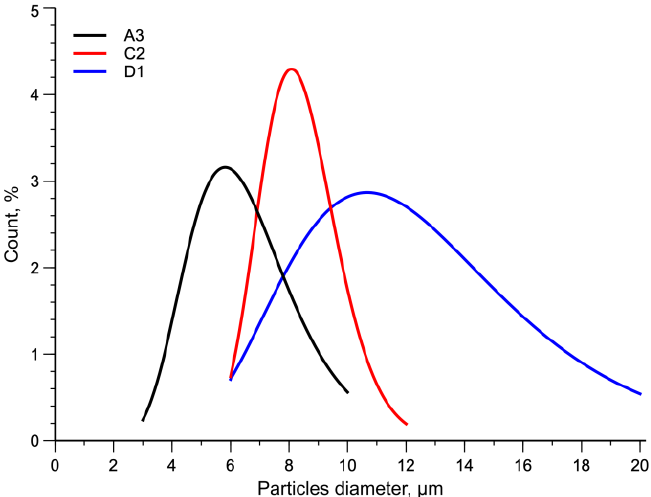
Figure 4. Normal distribution curves of particles diameter.